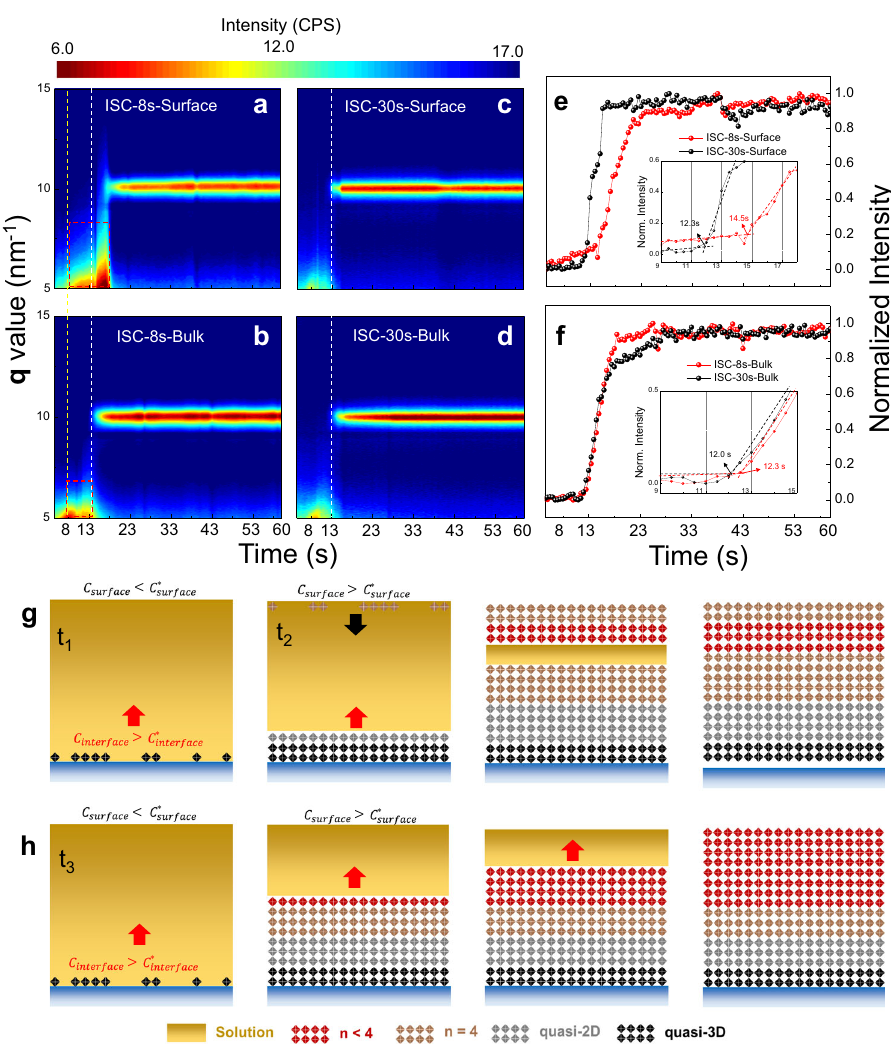
Fig. 4 Crystallization comparison of thin- fi lms fabricated with ISC and SC methods. In situ GIWAXS mapping versus time and q vector during fi lm formation under a , b ISC-8s and c , d SC treatments along with the corresponding line-cuts at ~10 nm − 1 collected from the e surface (0.1°) and f bulk area (0.4°). Crystallization illustrations of g SC and h ISC method. Note t 1 ( t 3 ) and t 2 ( t 4 ) represent the time required to reach the critical concentration for the interface and surface, respectively, in SC (ISC) method. Given the fast crystal growth, the upward crystallization is already completed before the surface reaches t 4 in the ISC